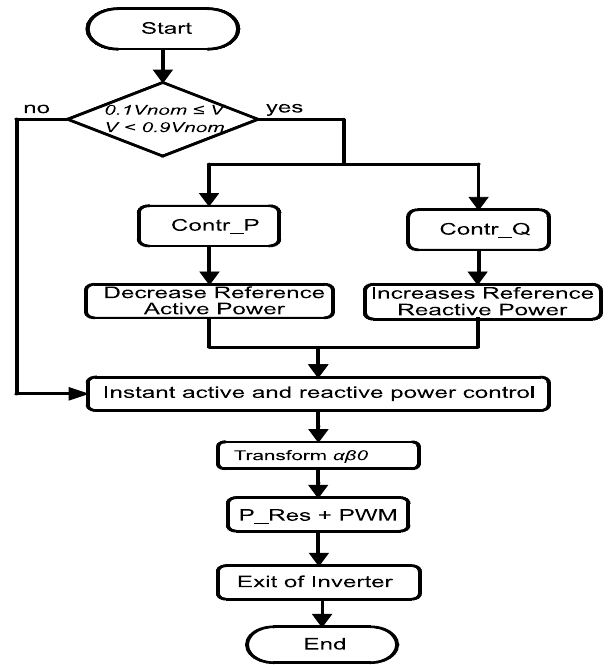
Figure 5. Flowchart of the SDVV/MVD control strategy.